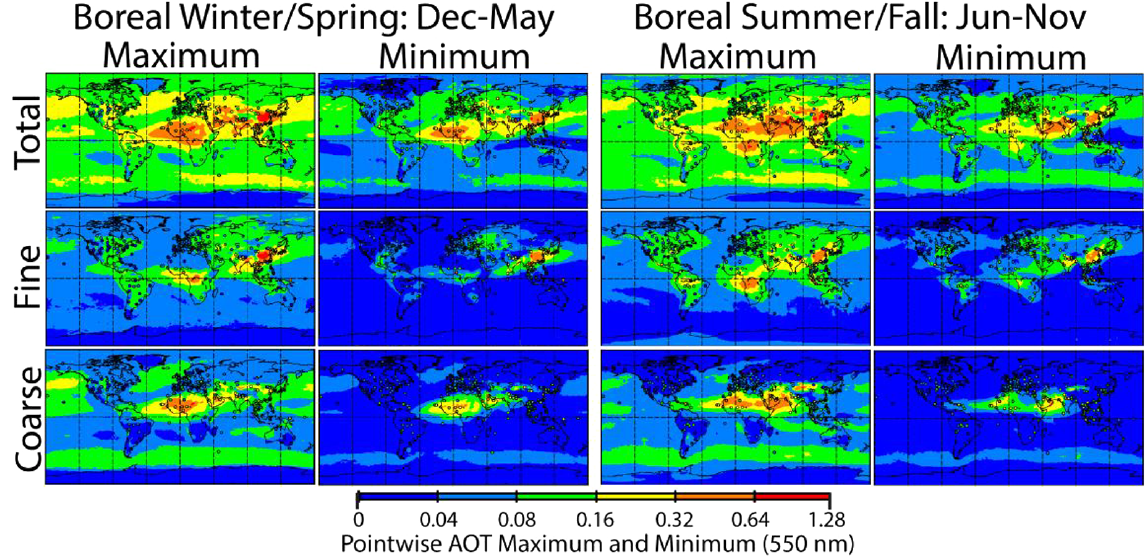
Figure 4. Same as Fig. 3, but for pointwise maximum and minimum 550nm AOTs drawn from the ICAP-MME’s four core member season- ally averaged AOT fields. AERONET circles represent AOT